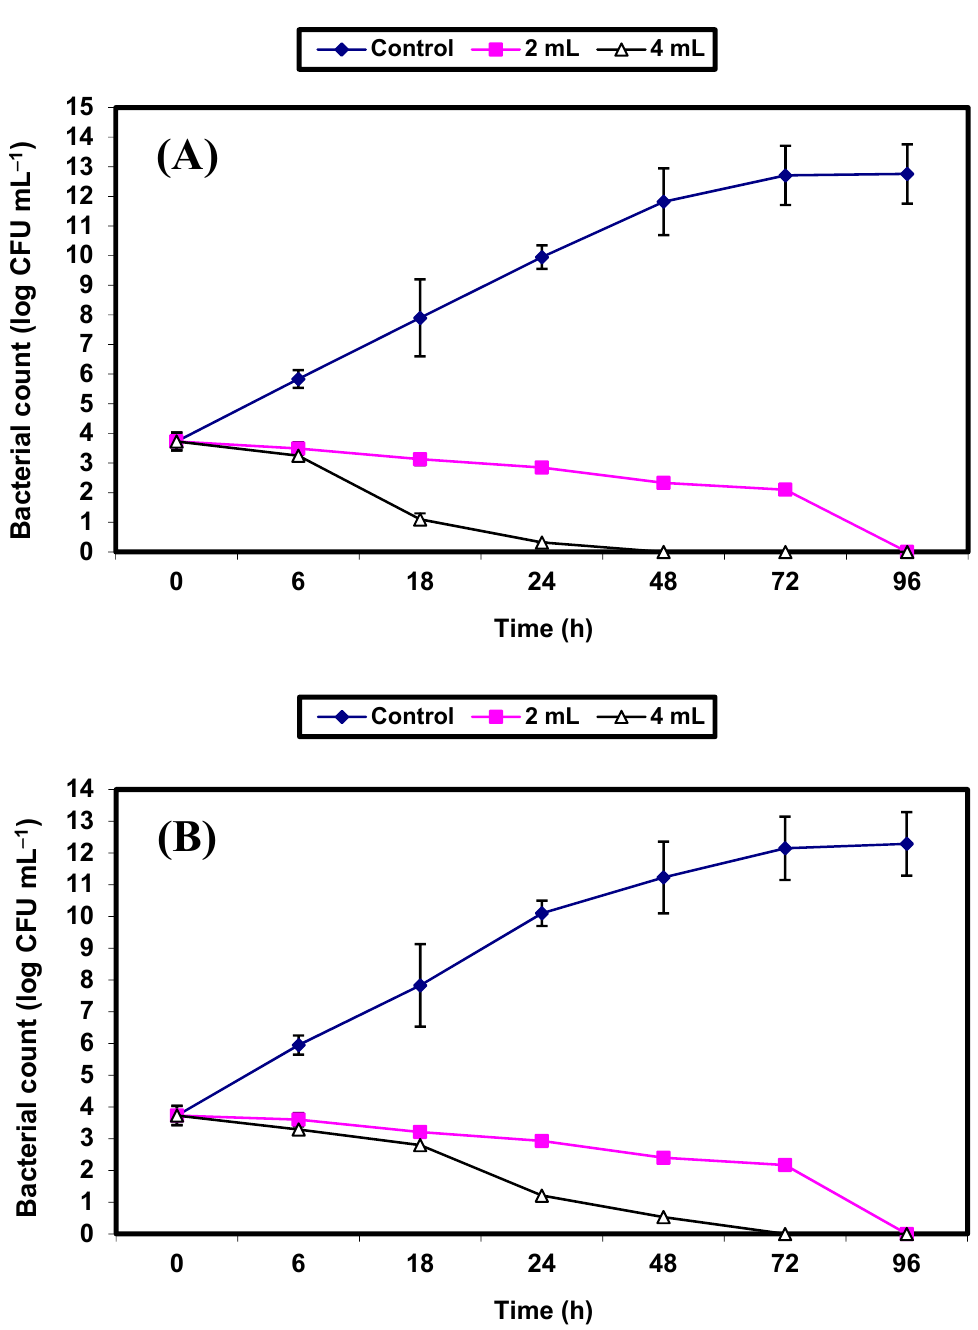
Figure 3. Inhibition of both S. aureus ( A ) and E. coli ( B ) in BHI broth. Symbols ♦ ; ■ ; ∆ refer to untreated control samples and juice samples treated with 2% and 4% KFB, respectively.